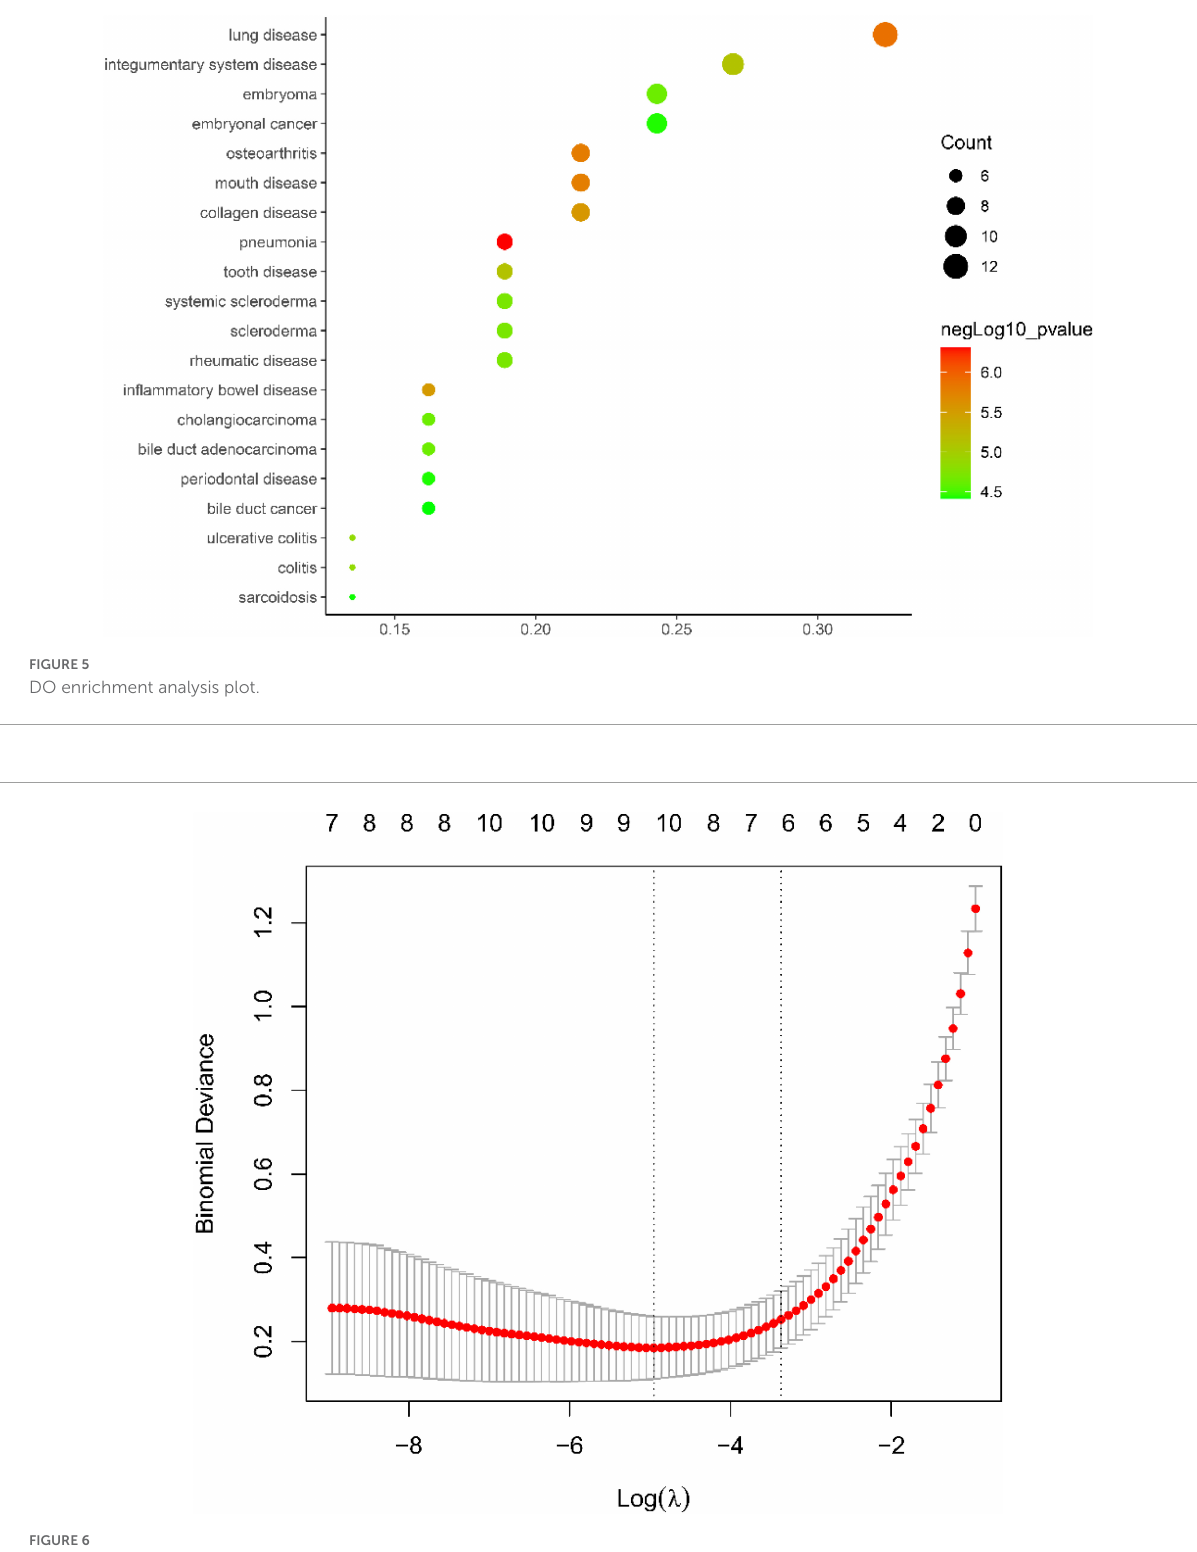
FIGURE6 Tuning traits selection in the least absolutem reduction and selection operator